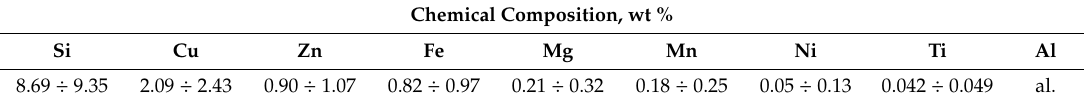
Table 1. Range of the chemical composition of the base EN AC-46000 alloy used for the tests. Chemical Composition, wt